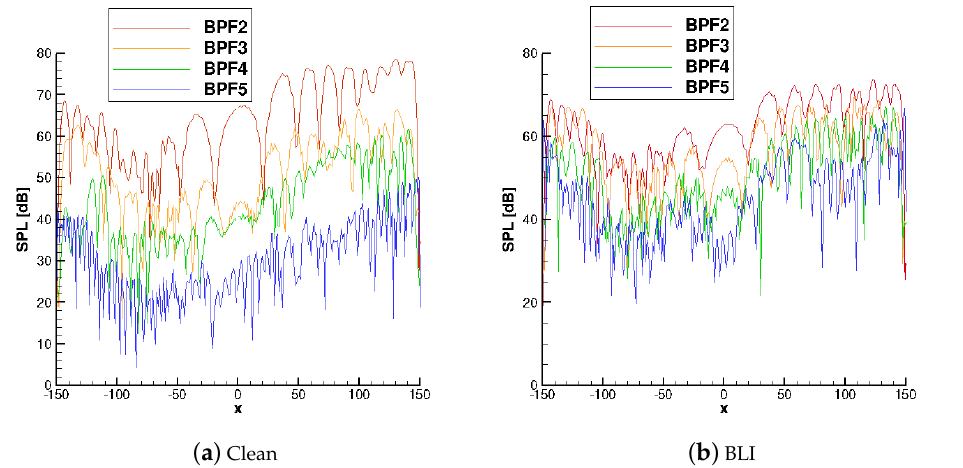
Figure 14. Comparison of direct acoustic field between the cases without ( a ) and with ( b ) boundary layer ingestion, along the Y